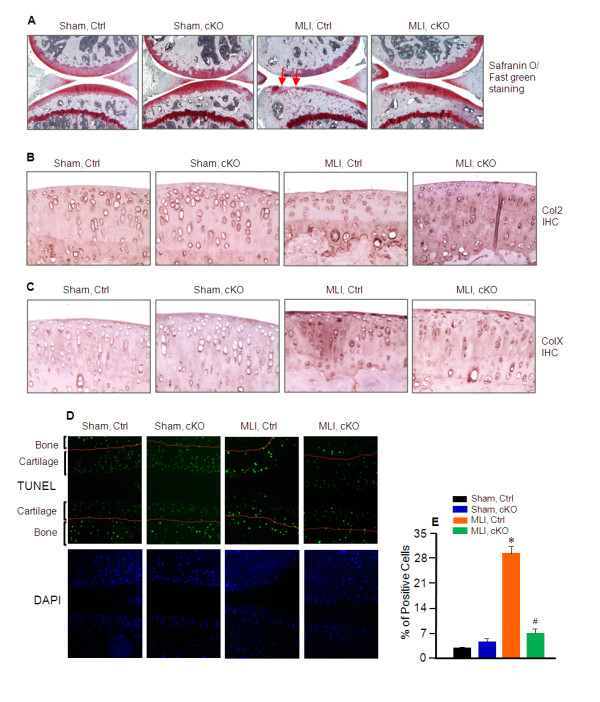
Decelerated osteoarthritis progression in Mmp-13Col2ER mice. Tamoxifen was administered when matrix metalloproteinase (MMP13) conditional knockout (cKO) mice (Mmp13Col2ER) and Cre-negative control mice were two-weeks-old (1 mg/10 g body weight, intraperitoneal injection, daily for five days). Meniscal-ligamentous injury (MLI) surgery was performed when the mice were 10-weeks-old. Knee joints were harvested eight weeks post-surgery. (A) Safranin O/Fast Green staining was performed to evaluate proteoglycan content. Proteoglycan loss following MLI was reduced in Mmp13Col2ER mice. (B) Type II collagen (Col2) loss following MLI was reduced in Mmp13Col2ER mice. Immunohistochemistry (IHC) of Col2 was performed to assess its protein level. (C) IHC of ColX was performed to assess its protein level. Type X collagen (ColX) induction following MLI was reduced in Mmp13Col2ER mice. (D) Terminal deoxynucleotidyl transferase dUTP nick end labeling (TUNEL) staining (in green) and 4',6-diamidino-2-phenylindole (DAPI) nuclear counterstaining (in blue) were performed to assess chondrocyte apoptosis. Chondrocyte apoptosis following MLI was reduced in Mmp13Col2ER mice. (E) Quantification of TUNEL staining positive cells was performed to assess chondrocyte apoptosis.